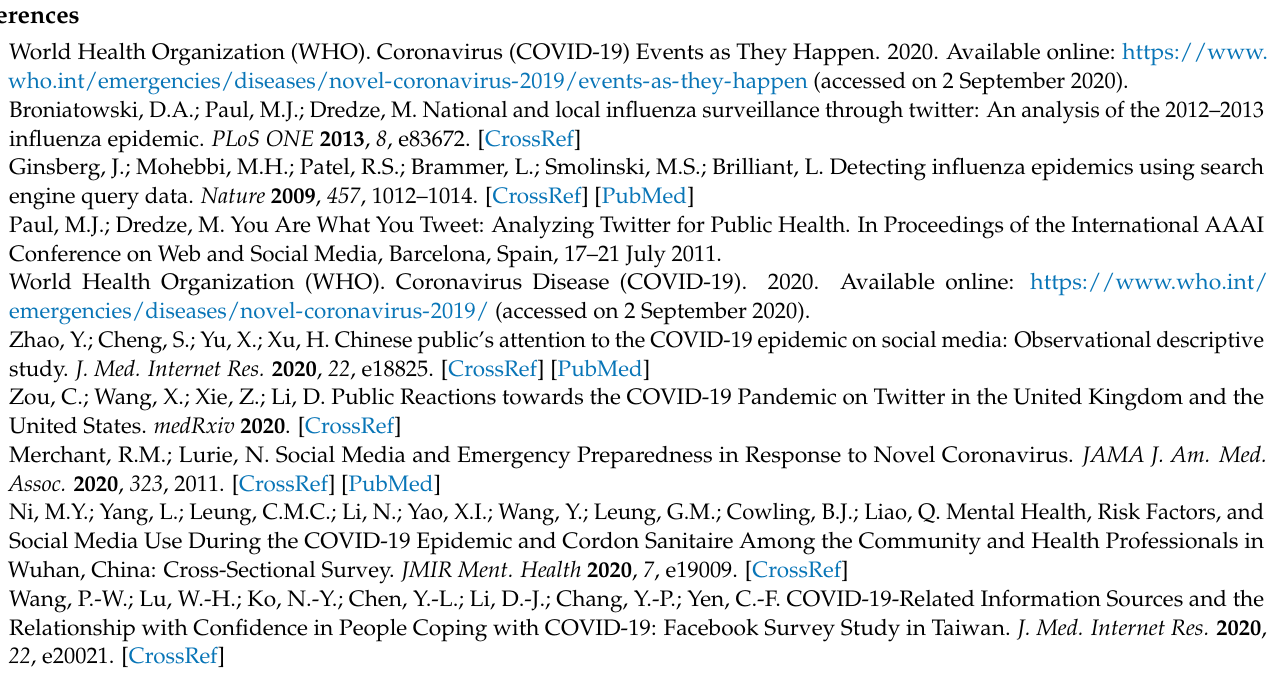
2020; Table S3: Spearman rho correlation between frequency of tweets expressing emotions and frequency of mentions of bigrams related to the different themes identified with the semantic anal- ysis. Figure S1: pairwise correlation between themes identified through the semantic analysis; Figure S2: the cross-correlation function between each emotion and variations in newly confirmed cases; Figure S3: the cross-correlation function between each emotion and daily number of subjects fined for specific violations of